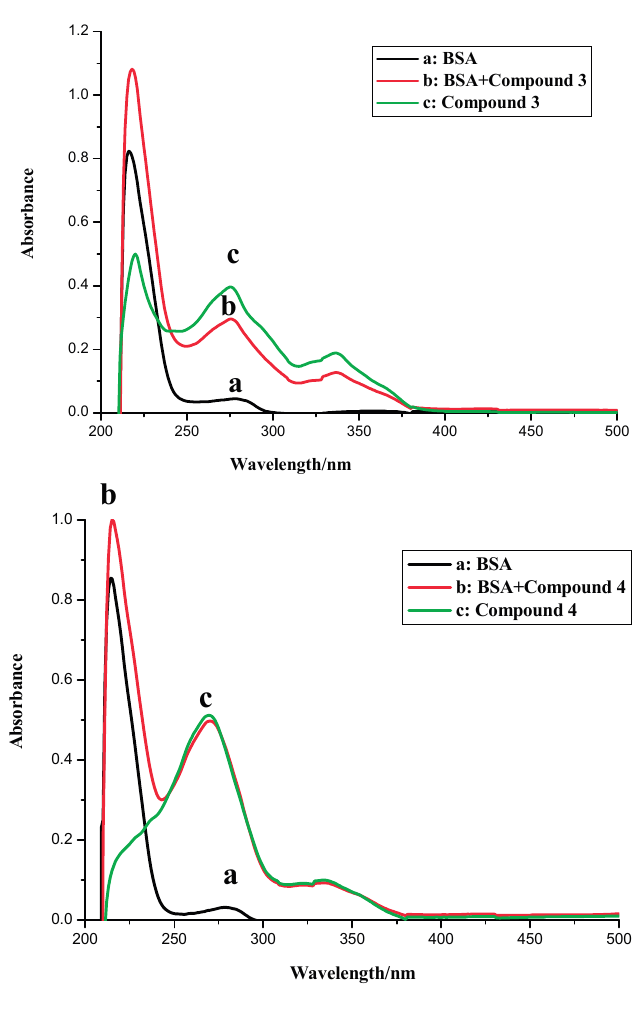
Figure 2. UV of compounds 1 – 4 , BSA and the BSA-compound complexes. Conditions: c (compound) = 12 × 10 − 6 mol·L − 1 ; c (BSA) = 1.04 × 10 − 6 mol·L − 1 .